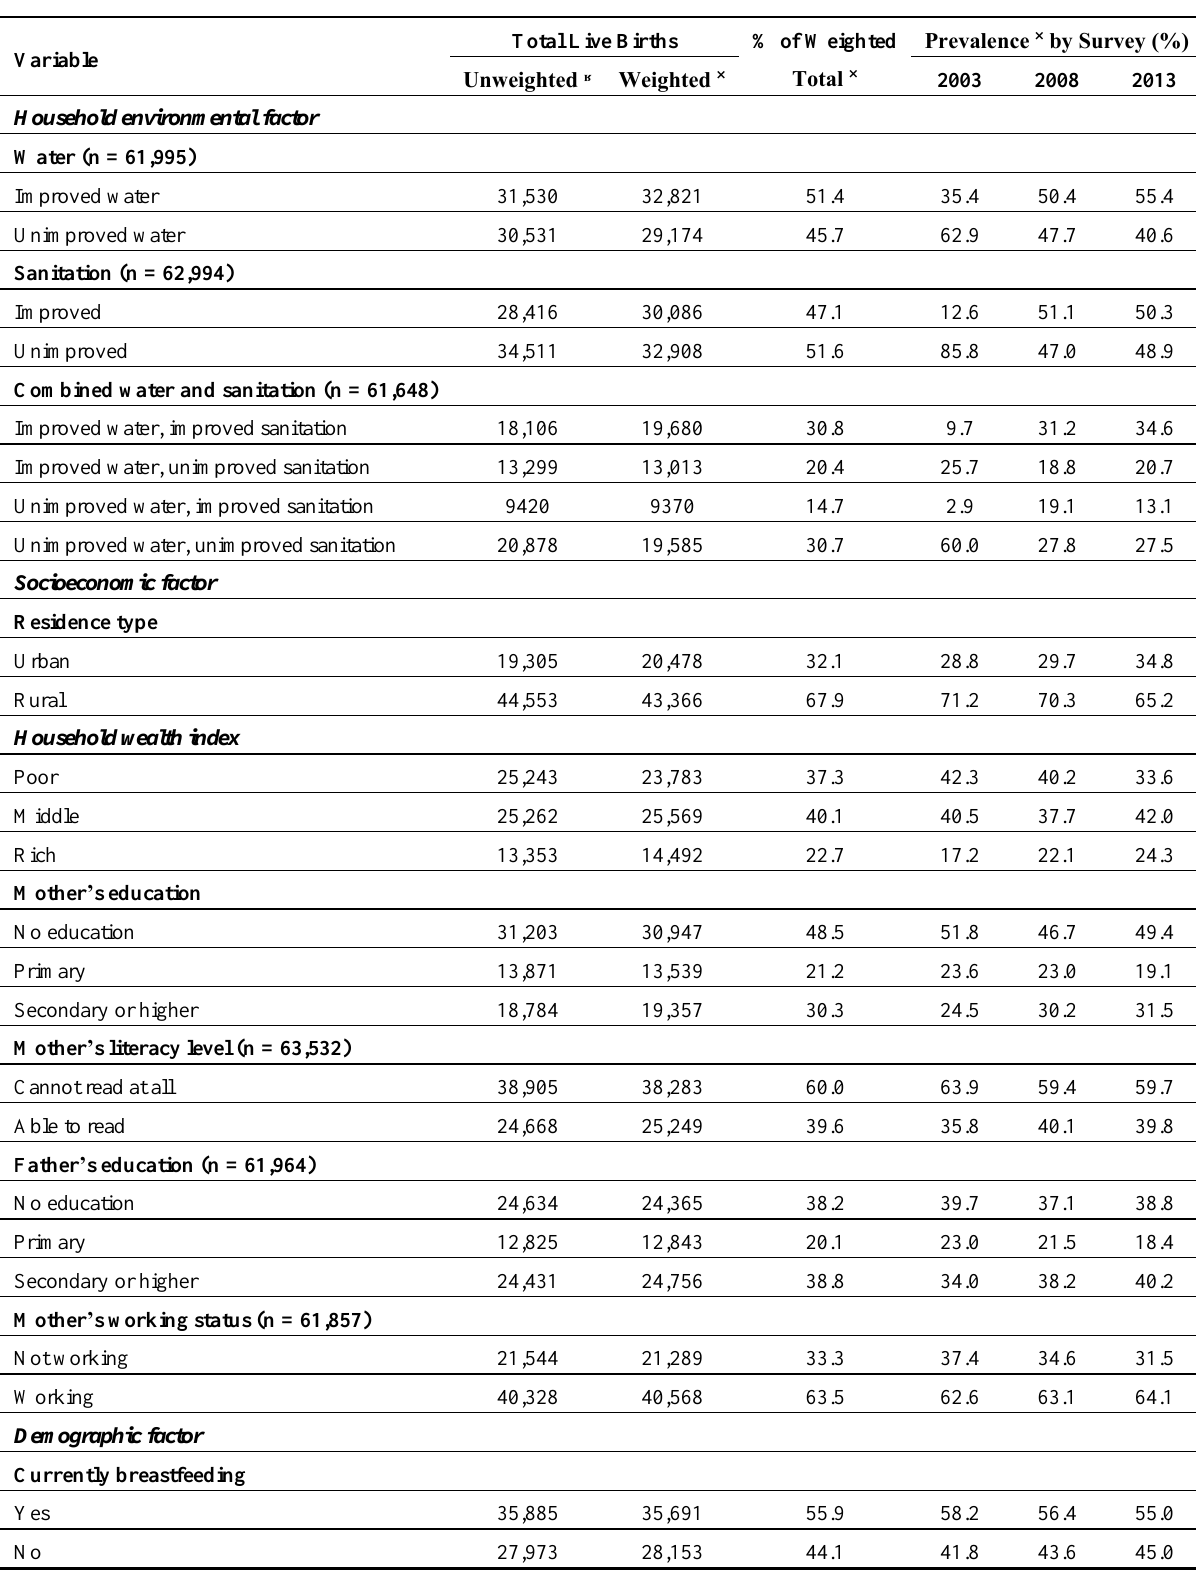
Table 2. The prevalence of singleton live birth of infants under 5 years old as reported by mothers interviewed during demographic and health surveys in Nigeria, 2003–2013 (n =